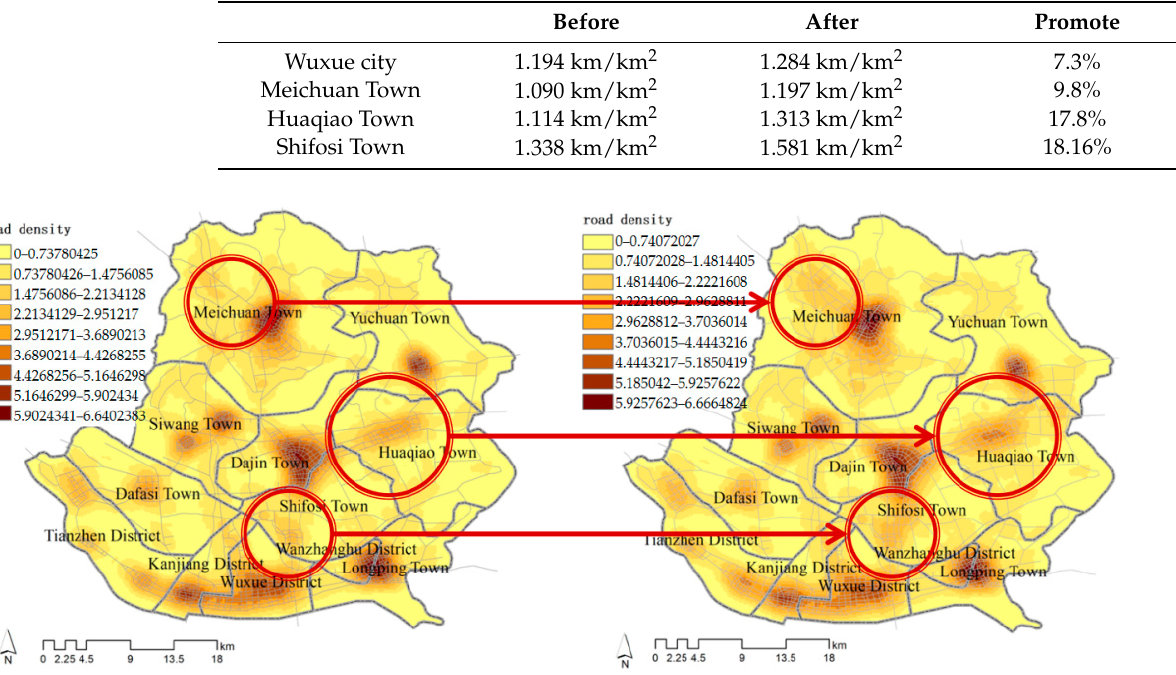
Figure 24. Comparison analysis of road network density before and after modification. Table 7. Comparison of the density before and after modification. Before After